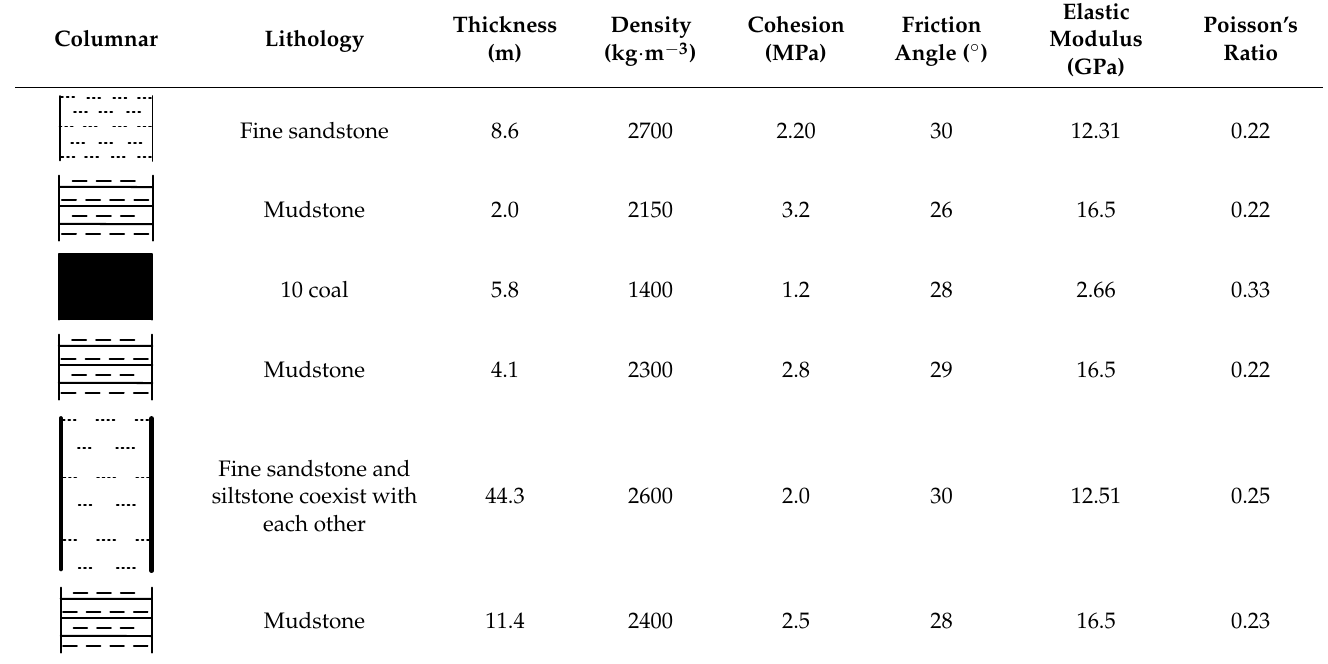
Table 5. Rock columnar and its physical-mechanical parameters. Thickness (m) Columnar Lithology